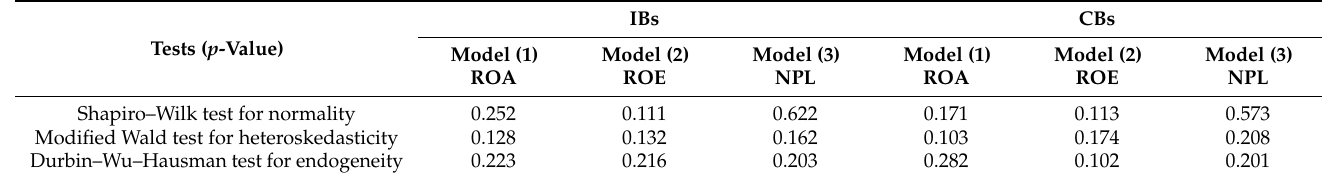
Table 3. Diagnostic